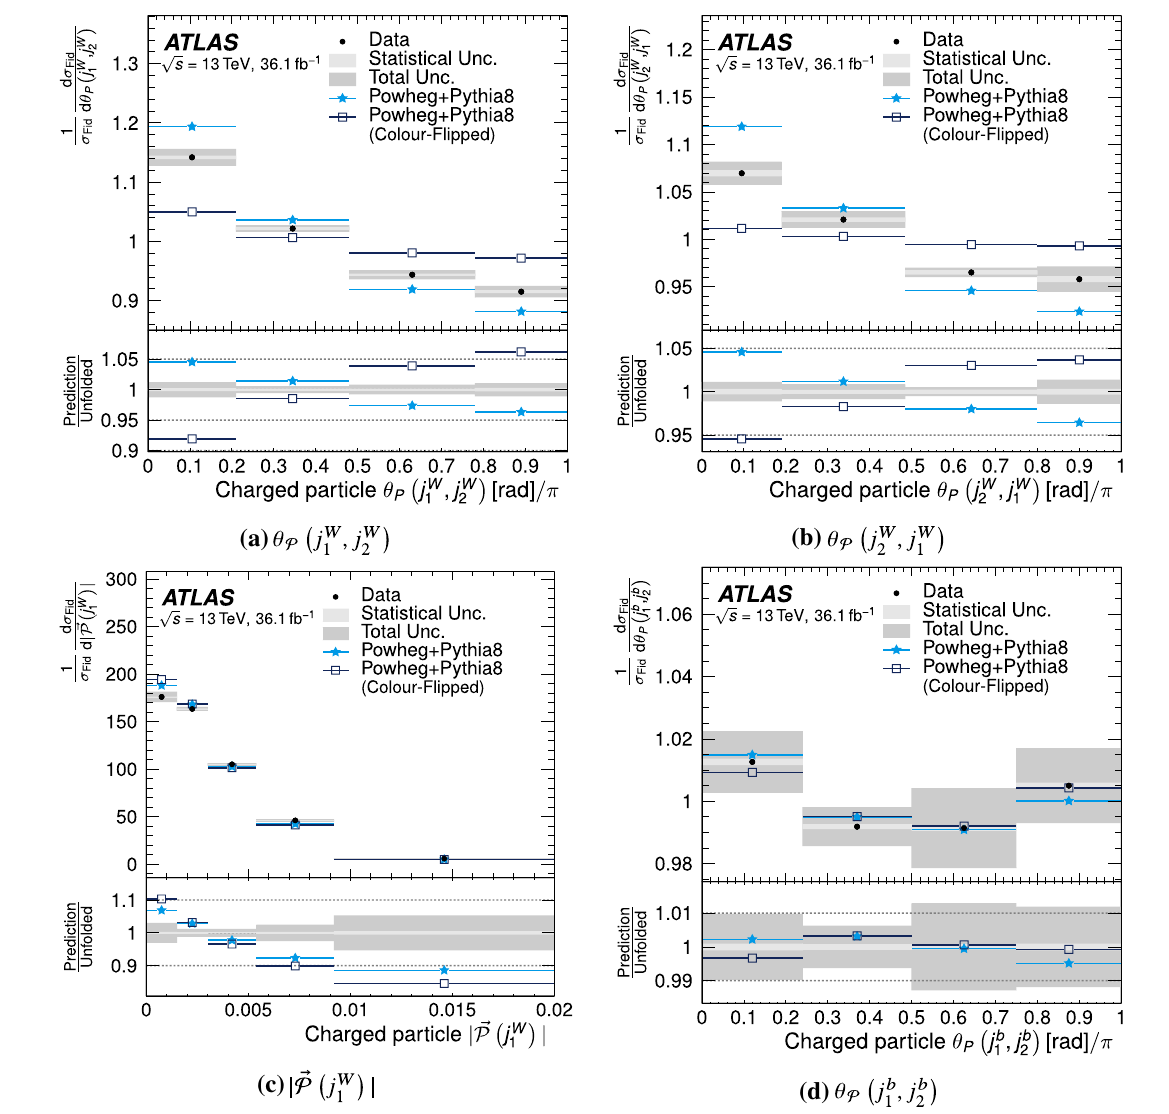
Fig. 6 Normalised fiducial differential cross-sections as a function of the a forward and b backward pull angle for the hadronically decaying W boson daughters, c the magnitude of the leading W daughter’s jet- pullvector,and d theforwarddi- b -jet-pullangle.Thedataarecompared to a SM prediction produced with Powheg + Pythia 8 as well as the model with exotic colour flow also created with Powheg + Pythia 8.